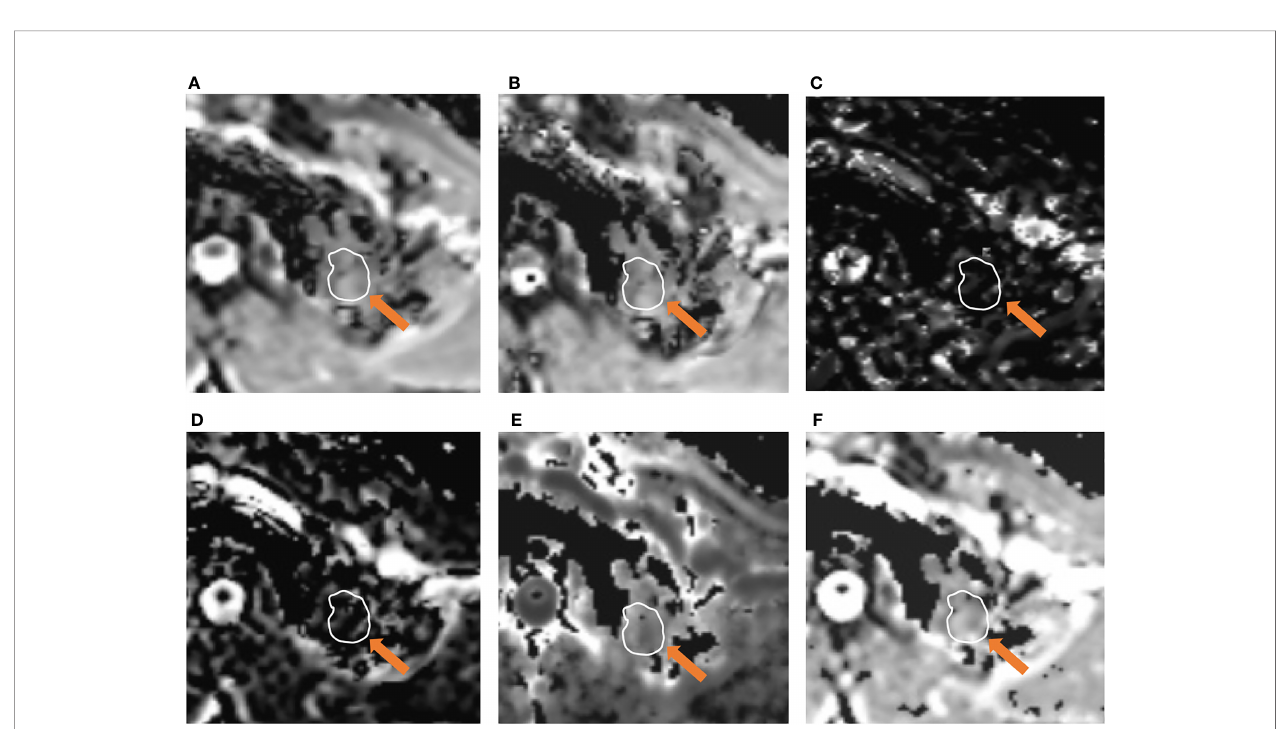
FIGURE 2 | A 51-year-old male was diagnosed with pulmonary tuberculosis in the left upper lobe. Parameter map of ADC, D, D*, f, Kapp, and Dapp calculated from multiple b-value DWI data (A – F) . The calculated mean values of ADC, D, D*, f, Kapp, and Dapp were 1.21×10 -3 mm 2 /s, 1.13×10 -3 mm 2 /s, 8.74×10 -3 mm 2 /s, 12.62%, 0.65, and 2.34×10 -3 mm 2 /s, respectively.